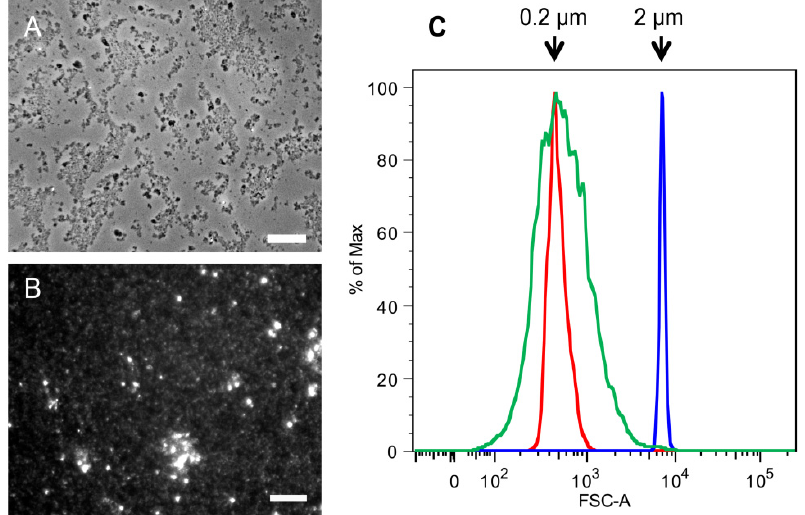
Figure 4. Comparison of SSCs and 2 k chitin particles from C. albicans yeast cells. Microscopic analysis of ( A ) 2 k chitin viewed by phase contrast microscopy; and ( B ) SSCs viewed by fluorescence microscopy after CFW staining; ( C ) Flow Cytometry analysis of SSCs. Red and blue indicate the profiles of 0.2 and 2 µm standard beads, respectively; green indicate the profile of SSCs. Bars, 10